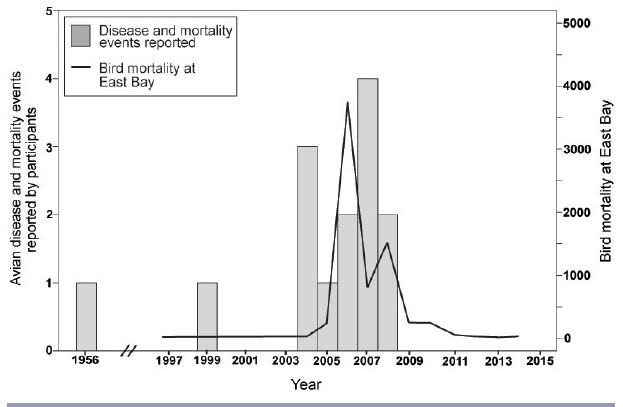
Fig. 7 . Number of avian disease and mortality events reported by participants from all four surveyed communities (Kimmirut, Cape Dorset, Coral Harbour, and Igloolik) and bird mortality (in number of birds) at the East Bay eider colony (2004–2014). Individual mortalities at East Bay were confirmed through laboratory analysis.